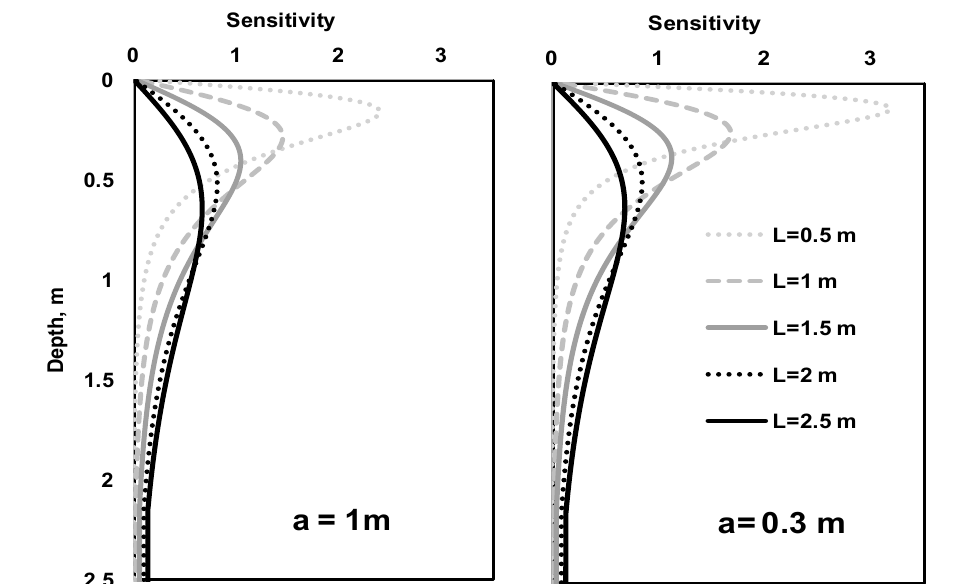
Figure 2. The sensitivity-depth-curves with dipole spacing ( L ) varying from 0.5 m to 2.5 m with 0.5 m increments and dipole lengths ( a ) of 1 m and 0.3